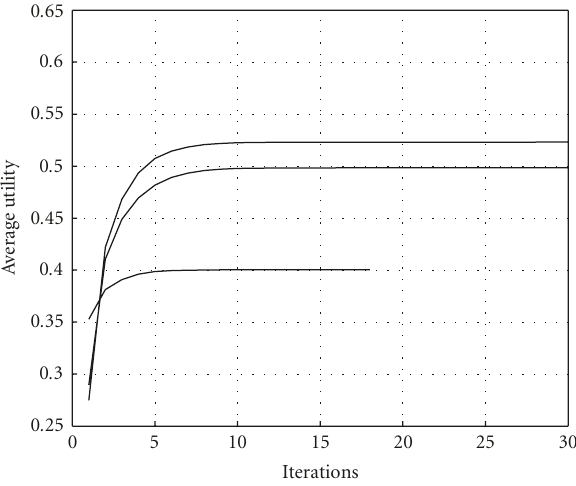
Figure 5: Average utility versus number of iterations, IEA method.